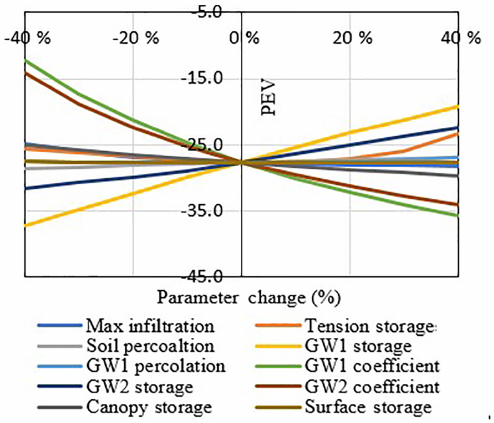
Figure 4. Percent Error in Volume of the Model Output due to Per- cent Change in Parameter Values.